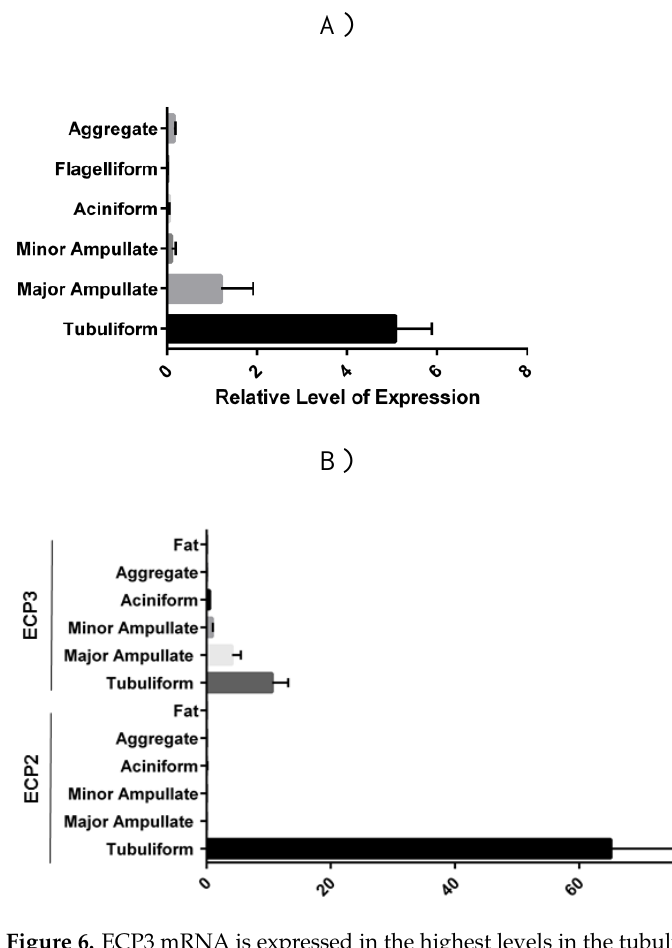
Figure 6. ECP3 mRNA is expressed in the highest levels in the tubuliform gland but has lower levels relative to ECP2 mRNA: ( A ) real-time RT-PCR analysis of ECP3 transcript levels in six different silk-producing glands; ( B ) real-time RT-PCR analysis of ECP2 and ECP3 mRNA levels in the five different silk-producing glands and fat tissue.